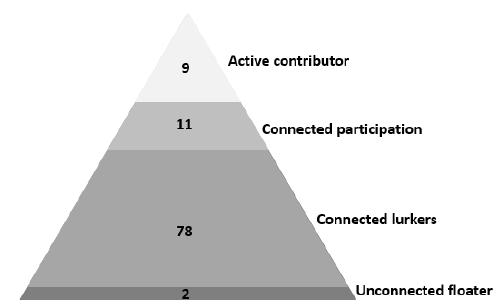
Figure 3 . Participant inequality in Change 11